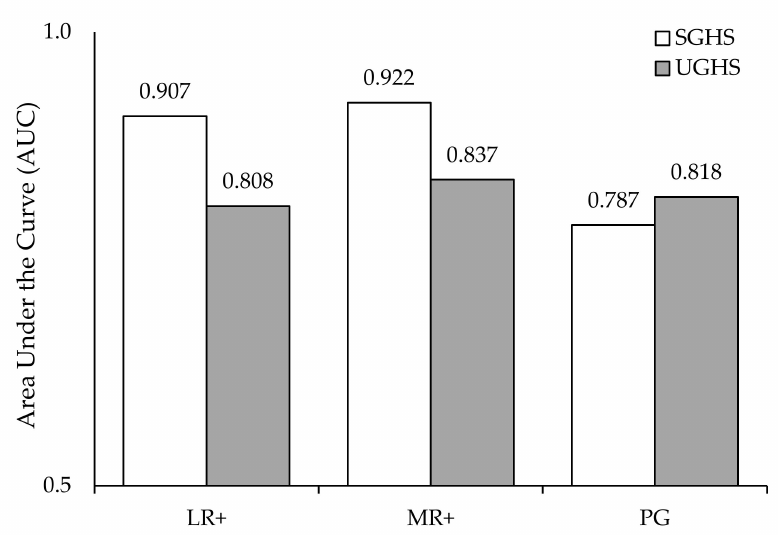
Figure 1. Areas under the curve when classifying respondents across different PGSI category thresholds.